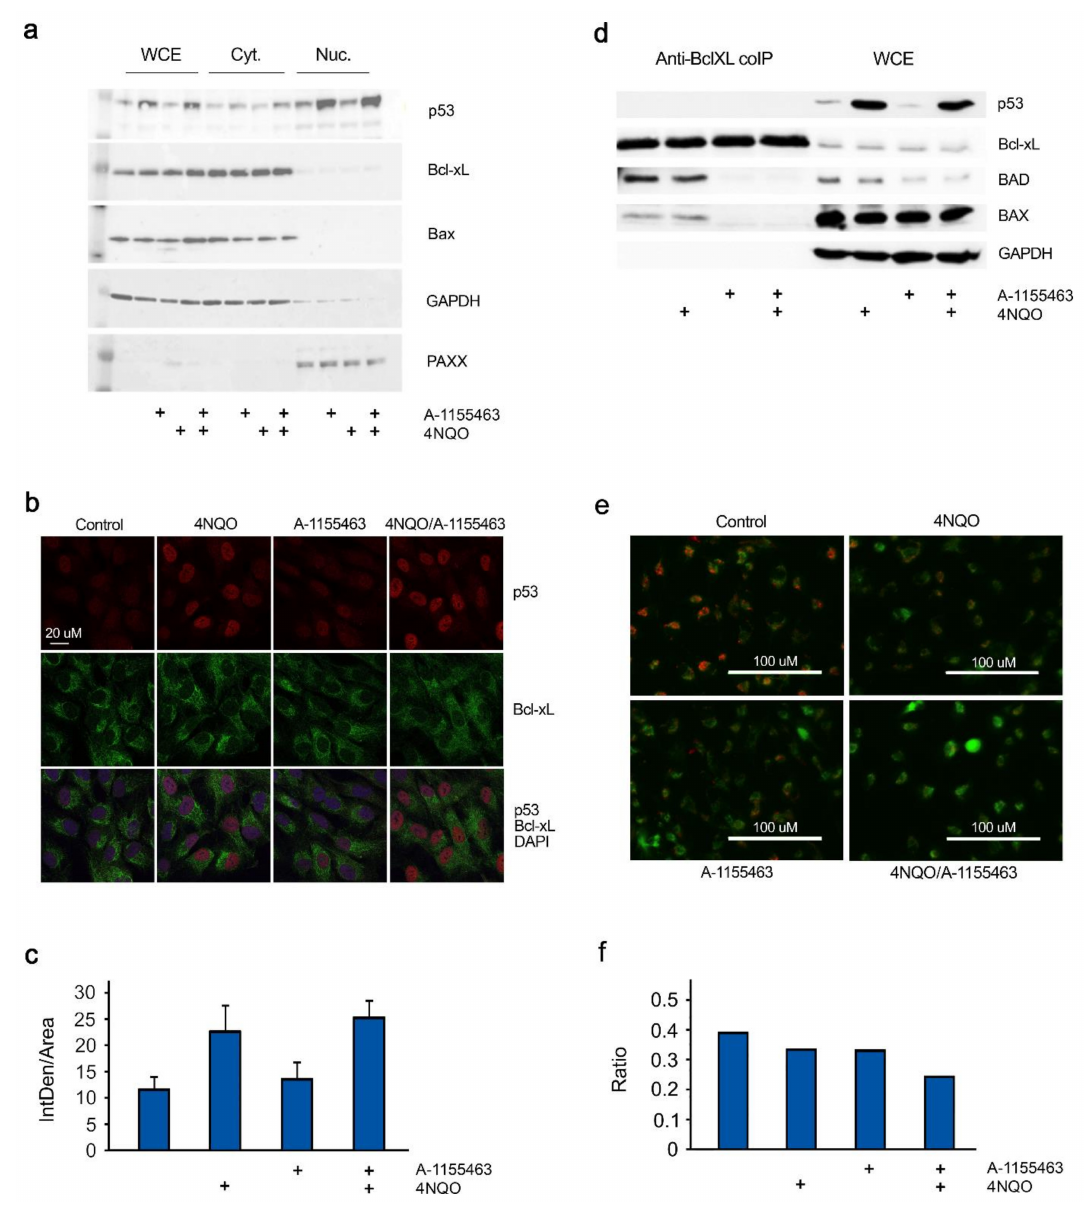
Figure 4. 4NQO induces p53 expression, while A-1155463 triggers release of pro-apoptotic Bad and Bax from Bcl-xL to initiate MOMP in RPE cells. ( a ) RPE cells were treated with 1 µ M 4NQO, 1 µ M A-1155463 or their combination. Control cells were treated with 0.1% DMSO. Nuclear and cytoplasm fractions were prepared. P53, Bcl-xL, Bax, XLF, PAXX and GAPDH were analysed using Western blotting. ( b ) RPE cells were treated as for (a). Two hours after treatment cells were fixed. P53 and Bcl-xL were stained with corresponding antibodies. Nuclei were stained with DAPI. Cells were imaged using a confocal microscopy and representative images (n = 8) were selected. Scale bar, 20 µ m. ( c ) Quantification of the red signal in the cells. ( d ) RPE cells were treated as for (a). Whole cell extracts (WCE) were obtained 2 h after treatment. Proteins were immuno-precipitated by anti-Bcl-xL antibody. P53, Bcl-xL, Bad, Bax, and GAPDH were analysed using Western blotting in WCE and immunoprecipitates. ( e ) RPE cells were treated as for (a). The mitochondrial potential was determined using JC-1 dye staining. The images of JC-1 staining were captured using fluorescence microscope and the mitochondrial potential was indicated by the shift of the fluorescence intensity ratio of J-aggregate (535 / 590 nm) and monomers (485 / 530 nm). Representative images (n = 3) were selected. Scale bar, 100 µ m. ( f ) Quantification of the ratios between the green and red signals (indicative of mitochondrial membrane